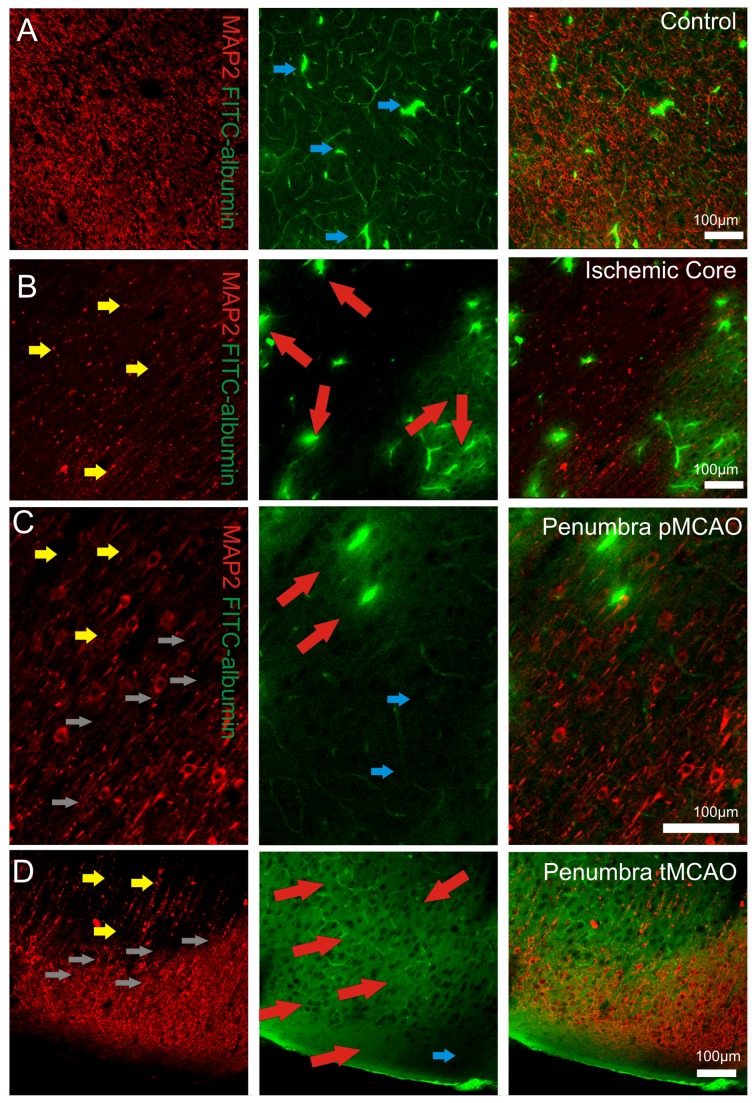
FITC extravasation in microvessels after MCAO.Representative confocal fluorescence images of MAP 2 (red), Fluorescein isothiocyanate –albumin (FITC-albumin; green) in the neocortex of pMCAO n = 3 brains and tMCAO n = 8 brains are depicted. Blue arrows mark intact regions of BBB that partly contain intraluminal entrapped FITC-albumin (note that no green halos are present around the vessels), yellow arrows indicate MAP 2 impairment, red arrows indicate FITC-albumin extravasation. In control hemispheres (contralateral to MCAO hemispheres) MAP 2 immunoreactivity was unaffected and FITC-albumin signals were found to be situated intraluminal (blu arrows, A). The ischemic core was characterized by a markedly reduced MAP 2 signal (yellow arrows, B) and areas of parenchymal FITC–albumin extravasation (red arrows) around vessels. In the penumbra transition zone of permanent MCAO (grey arrows, C) FITC-albumin extravasation (red arrows) was found to be present in areas where MAP2 signals were reduced (yellow arrows, C). In the penumbra transition zone (grey arrows, D) during transient MCAO followed by reperfusion we found a wide and diffuse parenchymal FITC–albumin extravasation (red arrows, D) that extended into areas with intact MAP2 immunoreactivity. The blue arrow marks the region where no FITC-albumin extravasation was found.